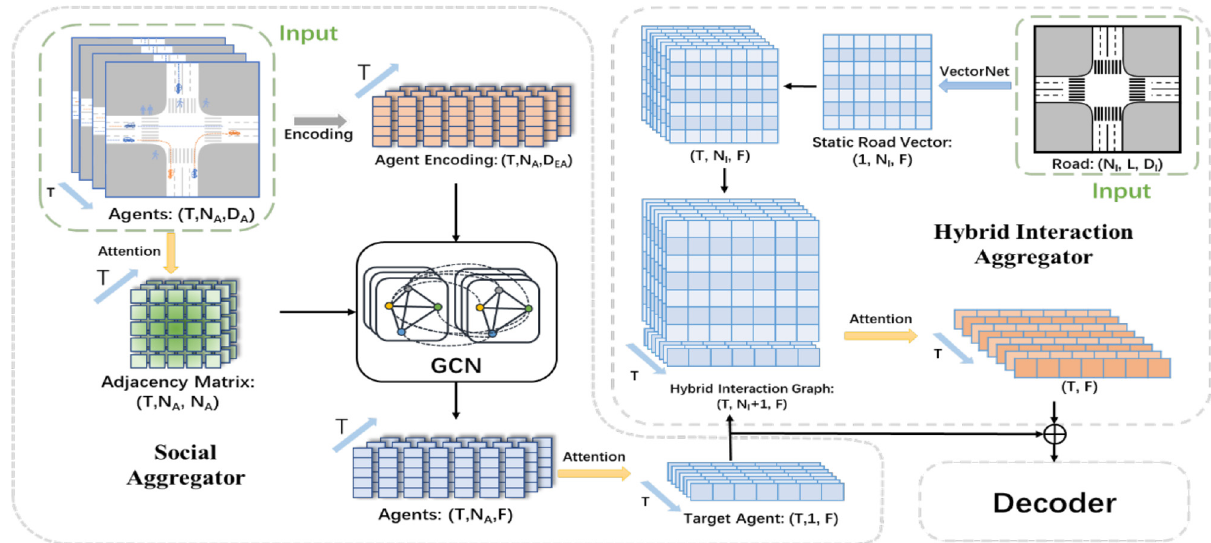
Figure 3 Details of social aggregator and lane